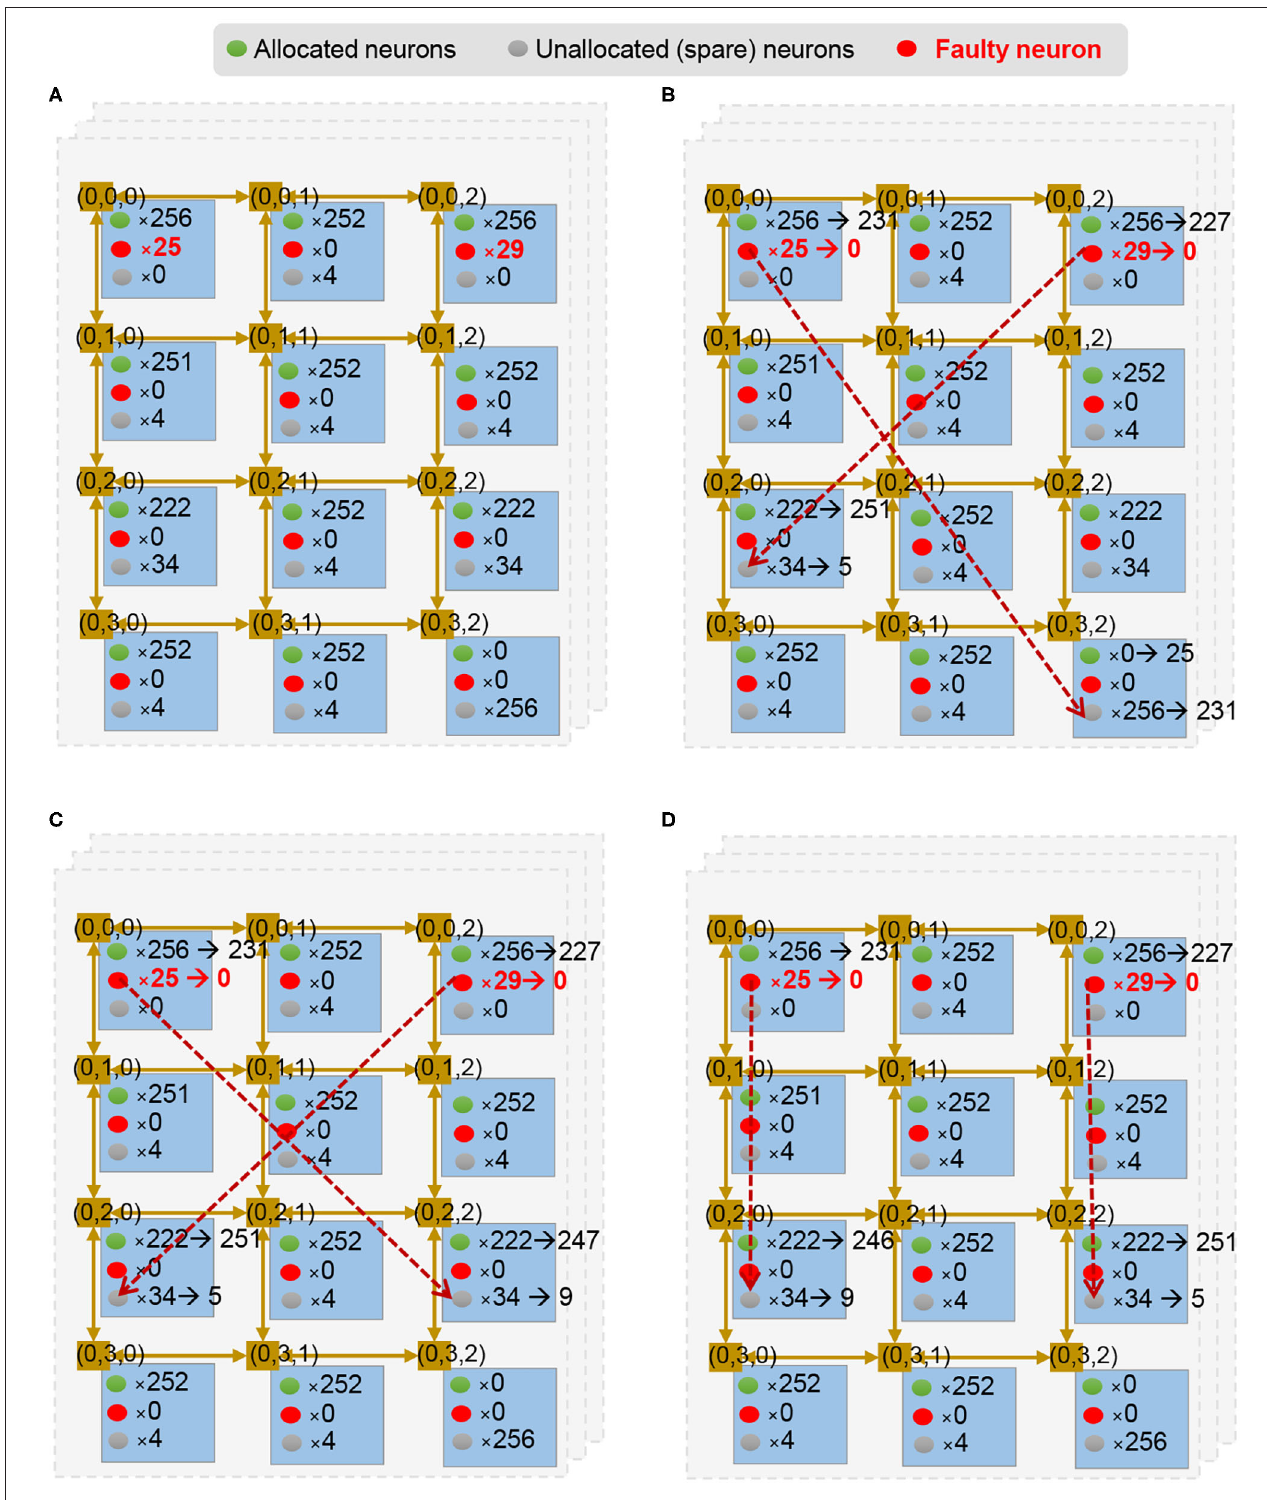
FIGURE 11 | Illustration of fault-tolerance remapping of the Genetic Algorithm. (A) Unmapped and free neurons per node. (B) A randomized mapping solution. (C) Mutating by finding a shorter distance for a flow; (D) Mutate by swapping destination of a flow.